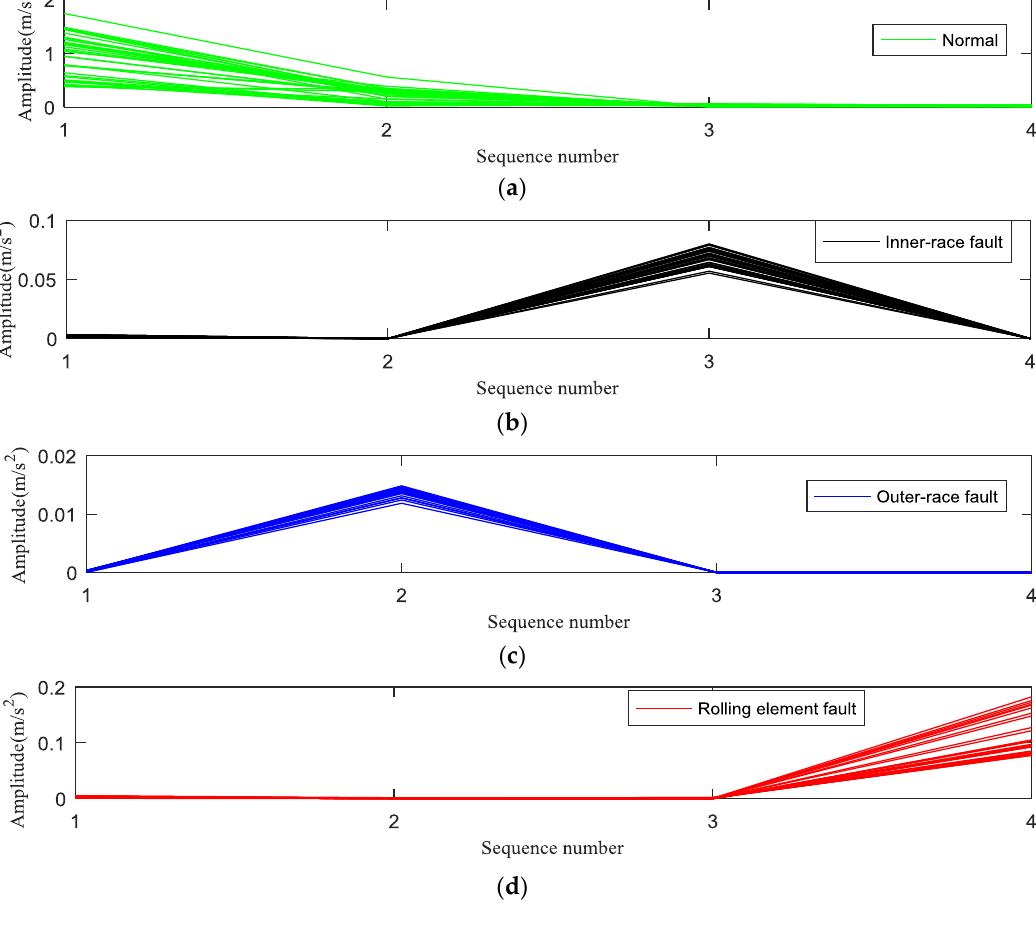
Figure 10. The fault feature vectors of: ( a ) the normal; ( b ) inner-race fault; ( c ) outer-race fault; ( d ) rolling element fault. Table 3. Description of the datasets.